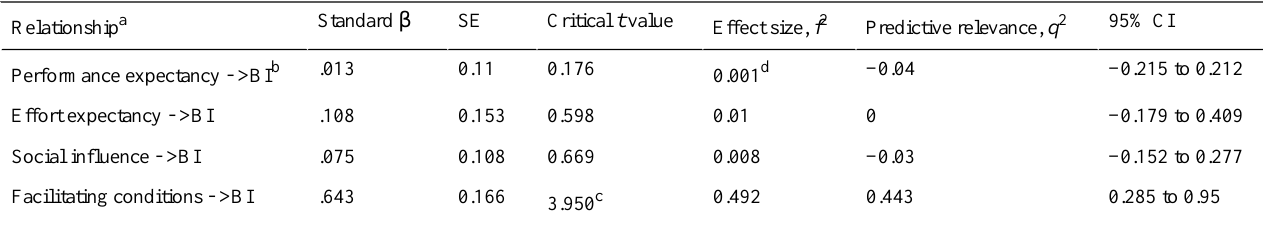
Table 6. Structural model evaluation and hypothesis